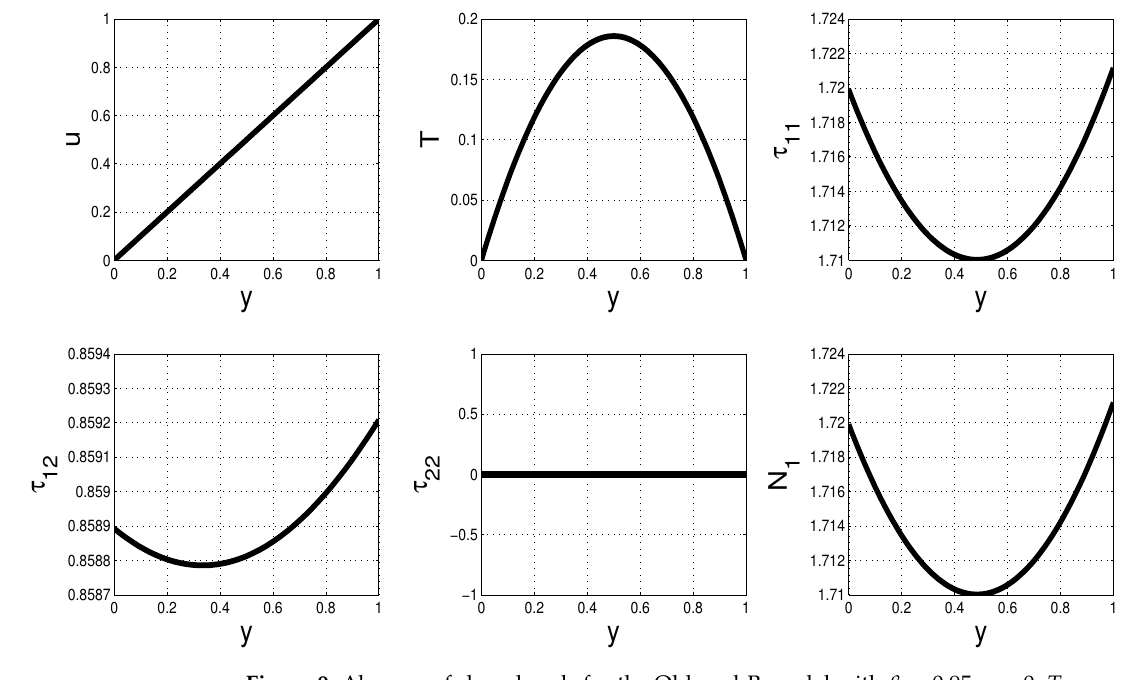
Figure 9. Absence of shear bands for the Oldroyd-B model with β = 0.95, ε = 0. Top-row from left to right velocity ( u ), temperature ( T ), and τ 11 -stress. Bottom-row from left to right τ 12 -stress, τ 22 -stress, and